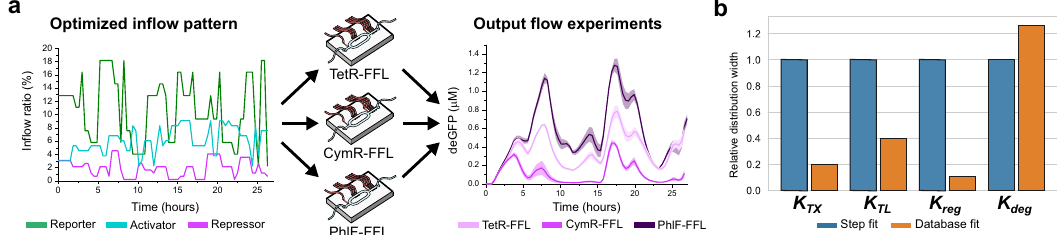
Fig. 3 Experimental pipeline and parameter estimation results. a Overview of the experimental process with the optimized in fl ow pattern (left) and output for all three IFFLs with RiboJ (right). Standard deviations from triplicate experiments are indicated in the shaded areas. b Normalized and averaged distribution widths per category are plotted for both the calibration step and database fi ts. The distribution widths are determined for each parameter separately as the ratio between the average of the fi ve highest and lowest values in the distribution, after which they are averaged per category and normalized to the distributions for the individual step experiments. The four parameter categories are transcription ( K TX ), translation ( K TL ), regulation ( K reg ) and degradation ( K deg ) as speci fi ed in Fig. 2b. For all separate parameter distributions see Supplementary